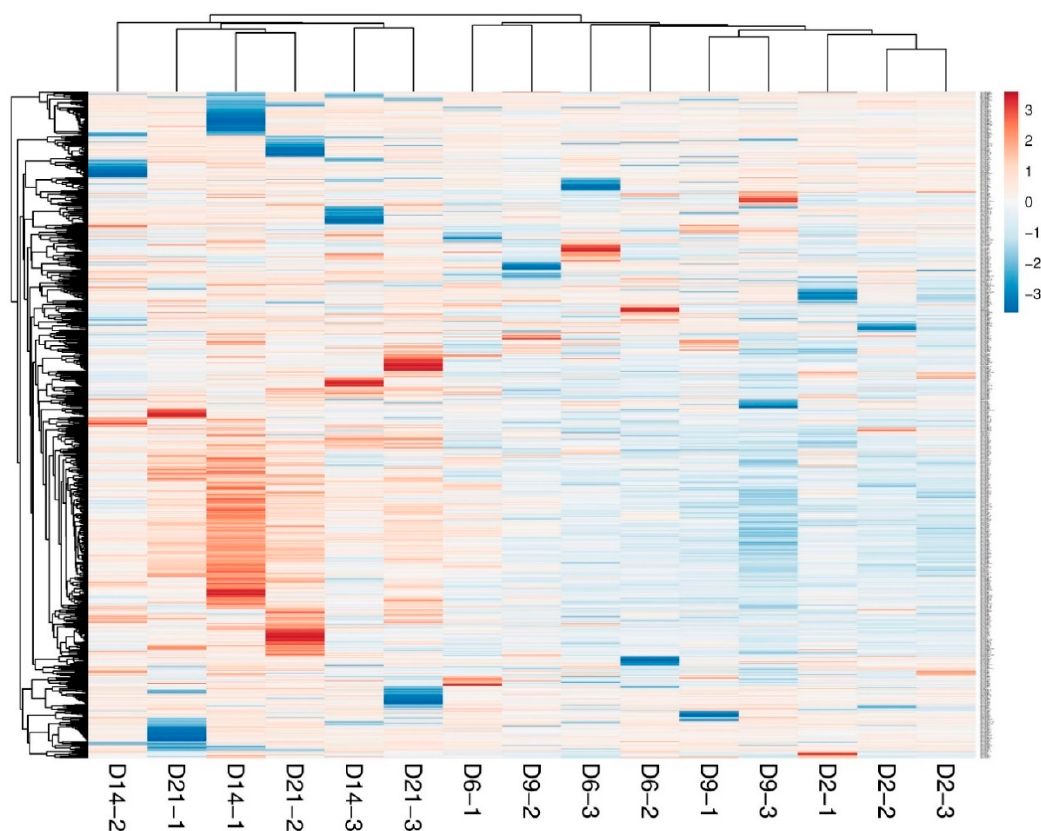
Figure 2. Heatmap illustrating the hierarchical clustering of samples according to the expression pattern of the plasma circulatory miRNAs profile. Groups are indicated in biological triplicates.